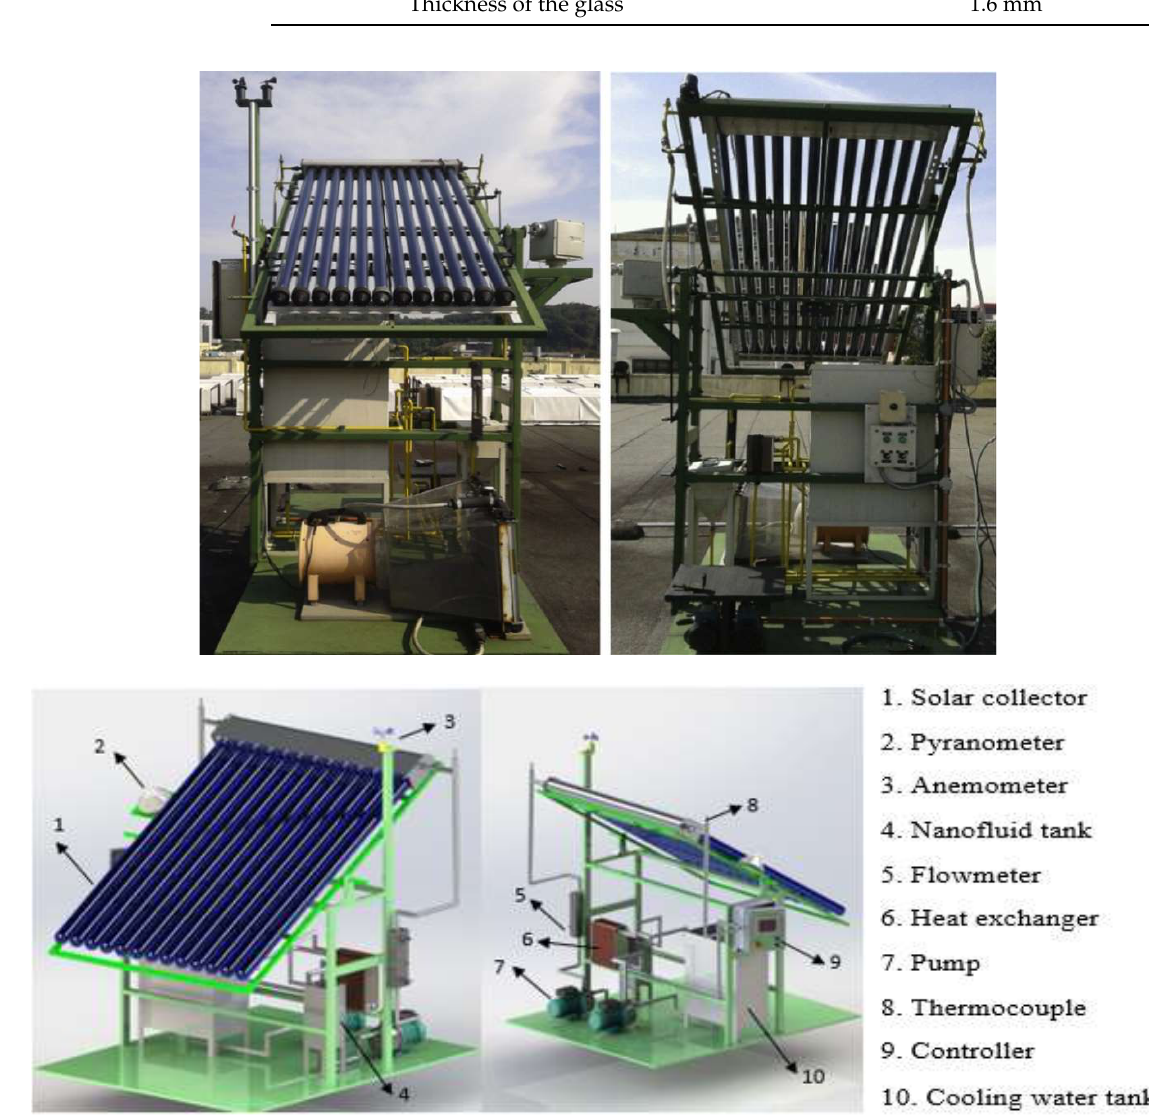
Figure 3. Schematic and picture of the evacuated tube solar collector (ETSC) system. The tilt angle is fixed at 30° to maximize the heat pipe’s performance and solar energy absorption. The volumetric flow rates are set in three cases of 0.5, 1.0 and 1.5 L/min. Table 1. Specifications of the experimental setup.